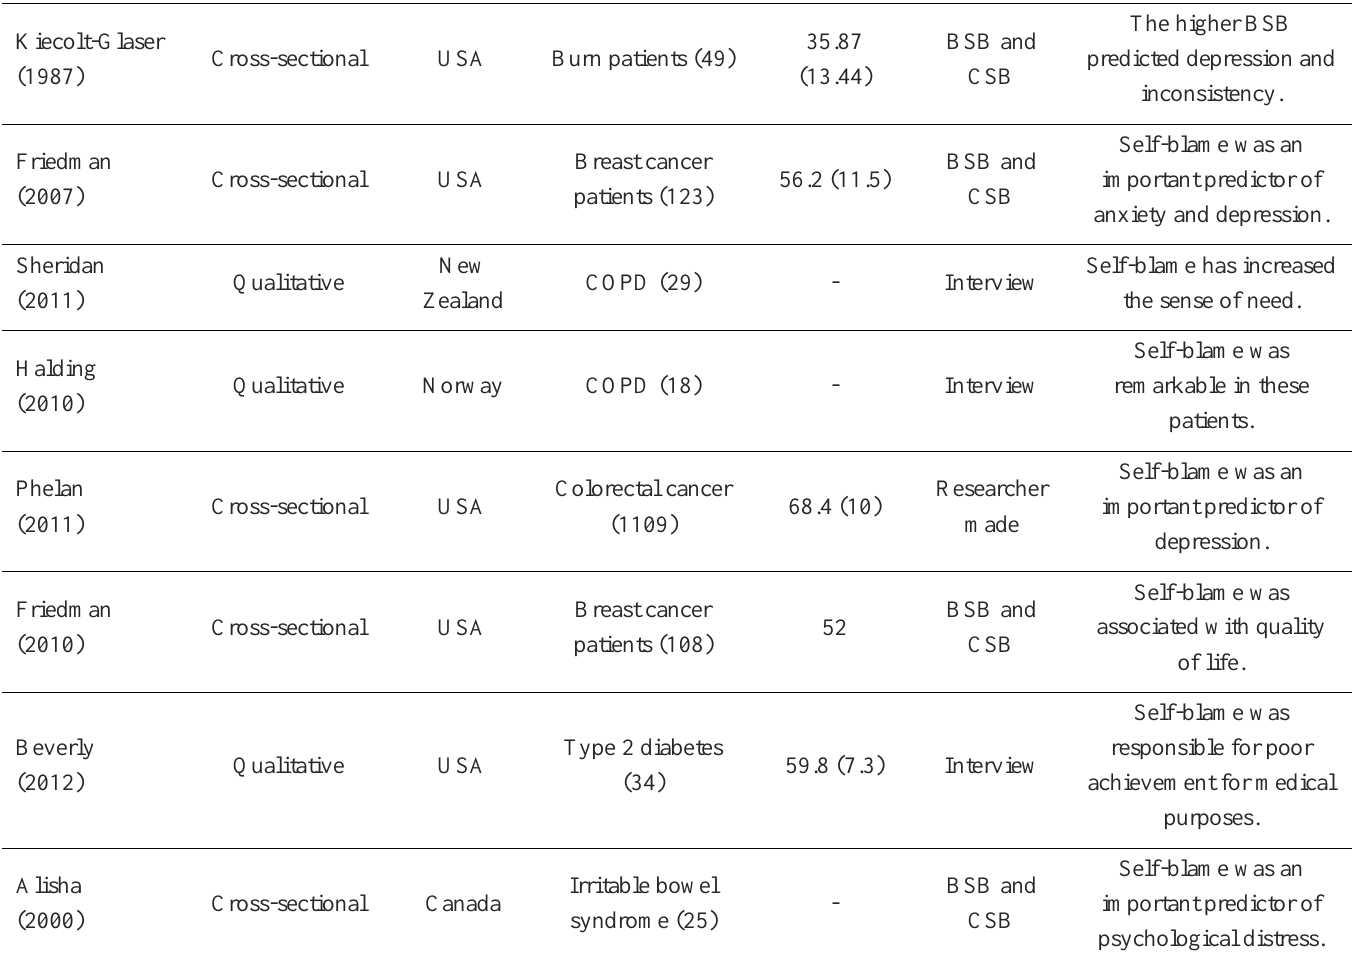
Table 2. Characterization of included